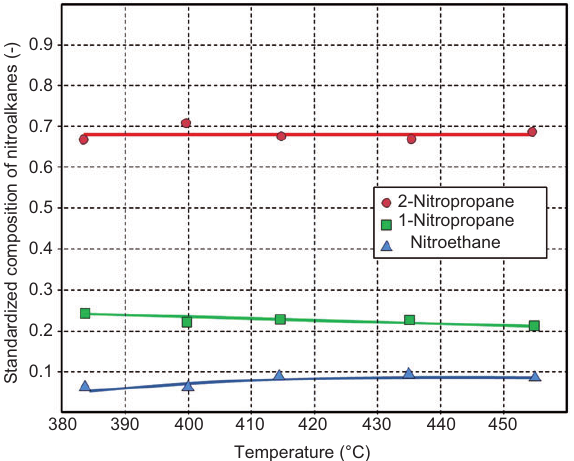
Figure 7 Standardized concentration ratio of nitroalkanes depend- ing on the applied reaction temperature. (The concentration of all nitro compounds is set to one, i.e., the standardized composition is a fraction